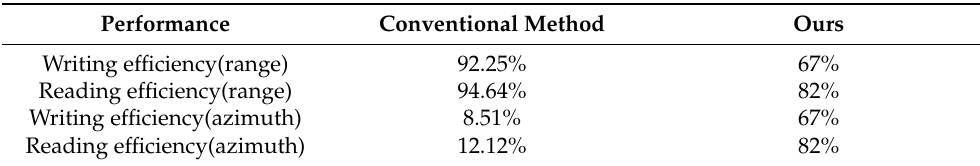
Table 2. Comparison of theoretical efficiency between conventional method and the method pro-